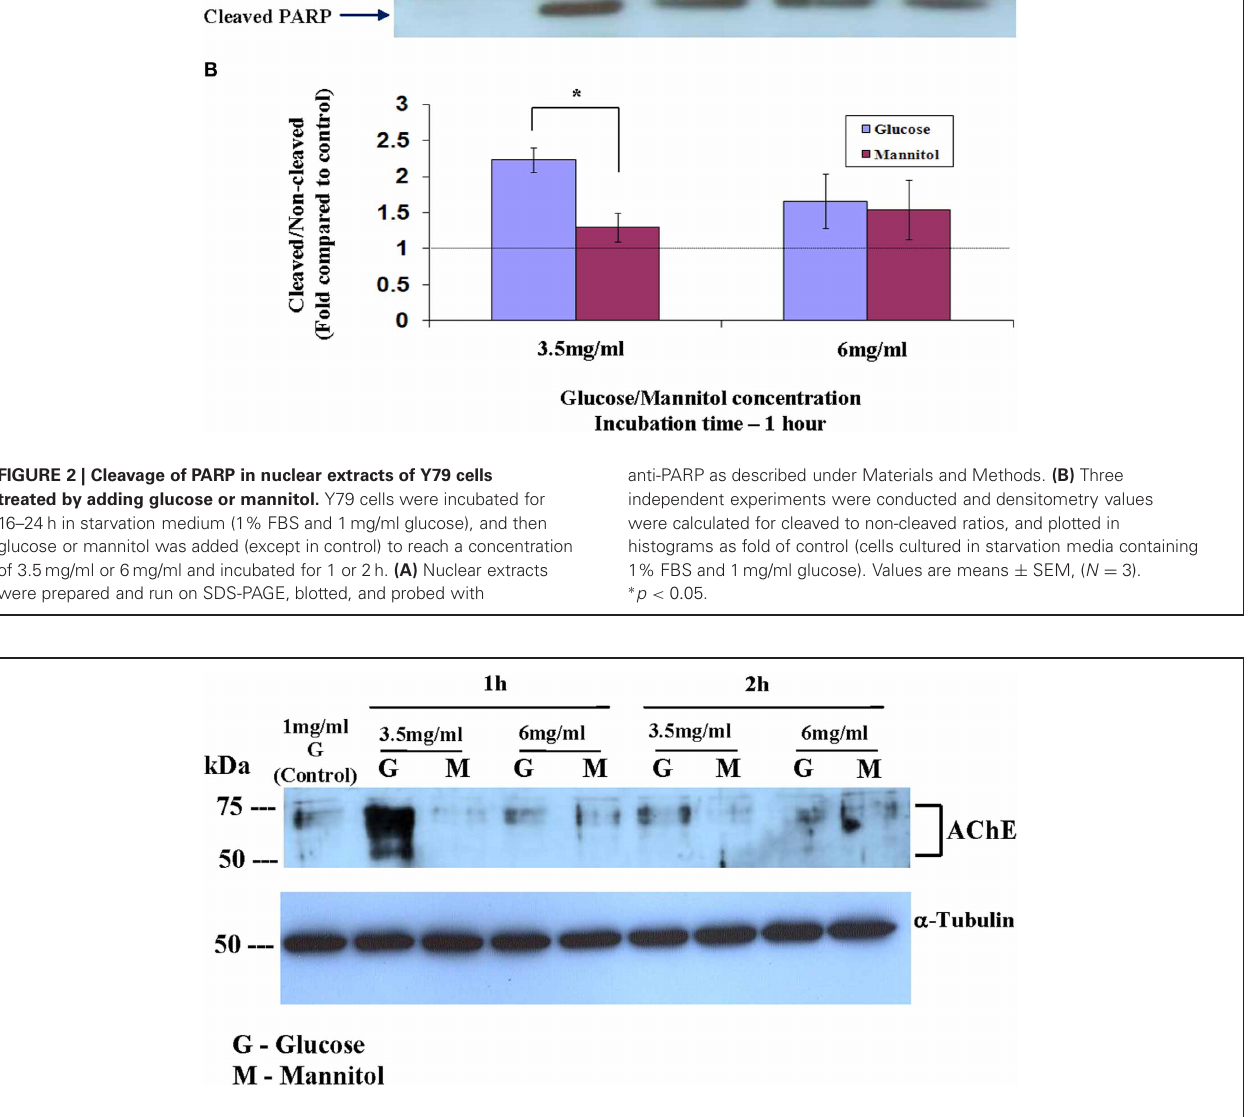
cytoplasmic extracts were prepared and run on SDS-PAGE, blotted, and probed with anti- AChE or anti- α -Tubulin (for loading control) as described under Materials and Methods. The western blot shown is one of two independent